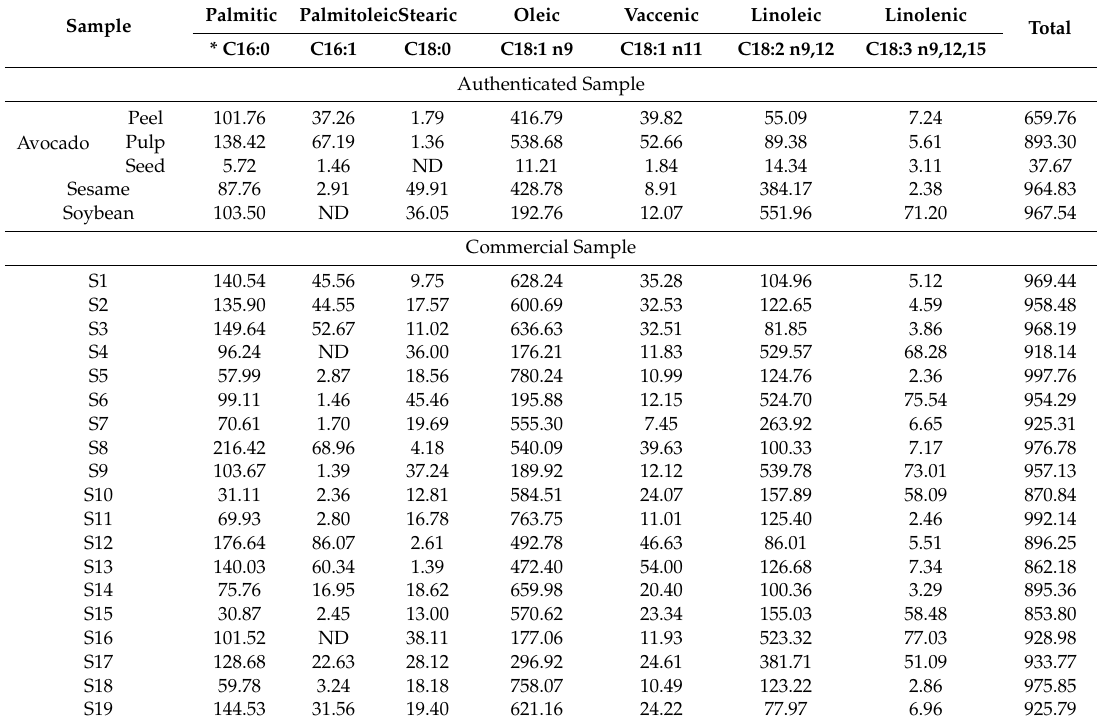
Table 4. Concentrations (mg / g) of FAs quantified in authenticated and commercial oils.